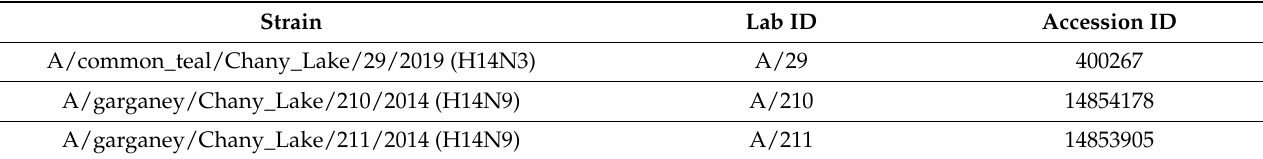
Table 1. H14-subtype AIV strain